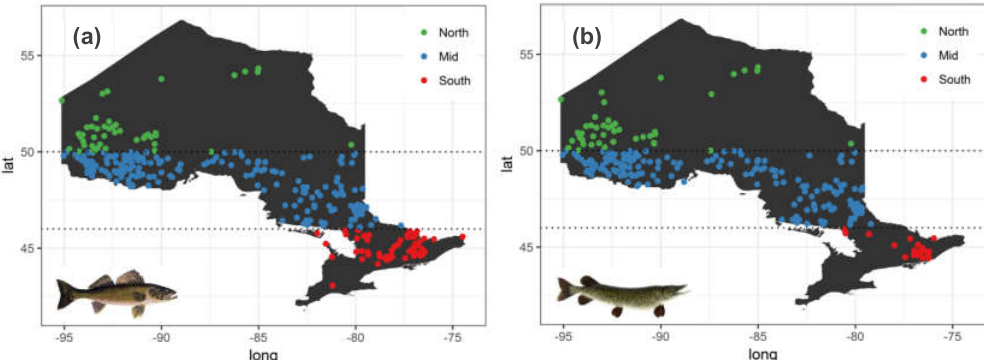
Figure 2. Distribution of ( a ) Walleye and ( b ) Northern Pike samples across the three defined latitudinal zones in Ontario obtained from the Broad Scale Monitoring program’s first sampling cycle between 2008 and 2012.